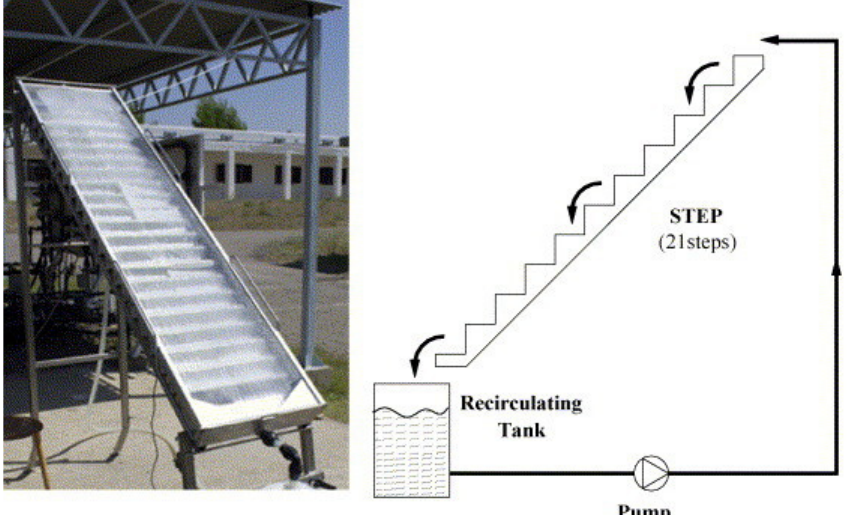
Figure 7. Non-concentrating solar collector tested at the Plataforma Solar de Almería , Spain (reproduced with permission of [141]).